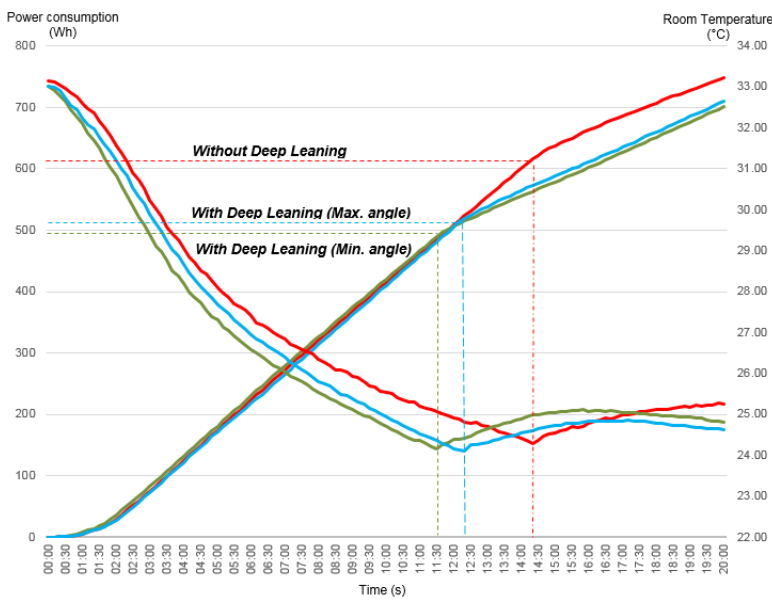
Figure 16. Environmental chamber test result according to